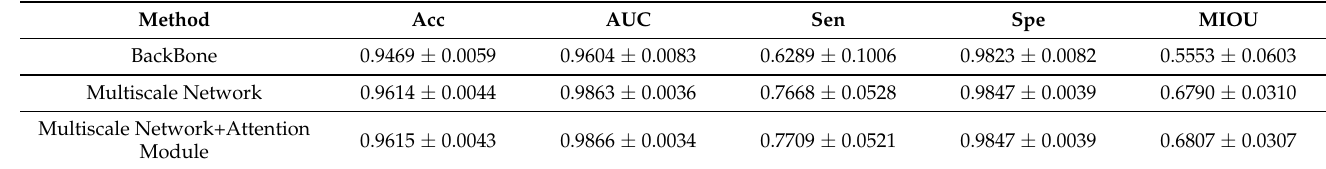
Table 3. The performance for each part of the DRIVE dataset inside FOV.